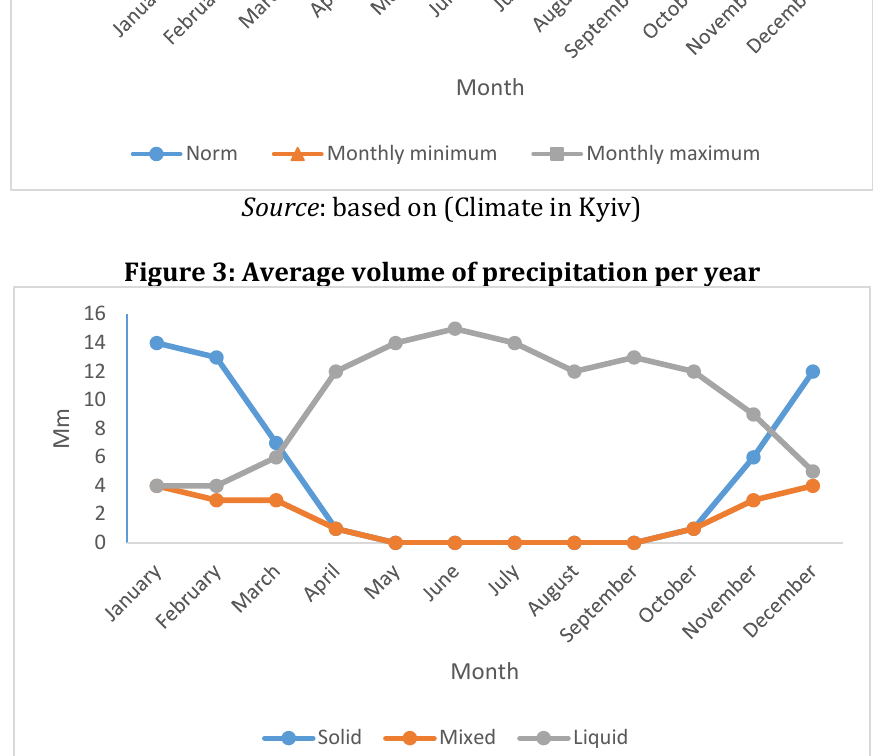
Source : based on (Climate in Kyiv)